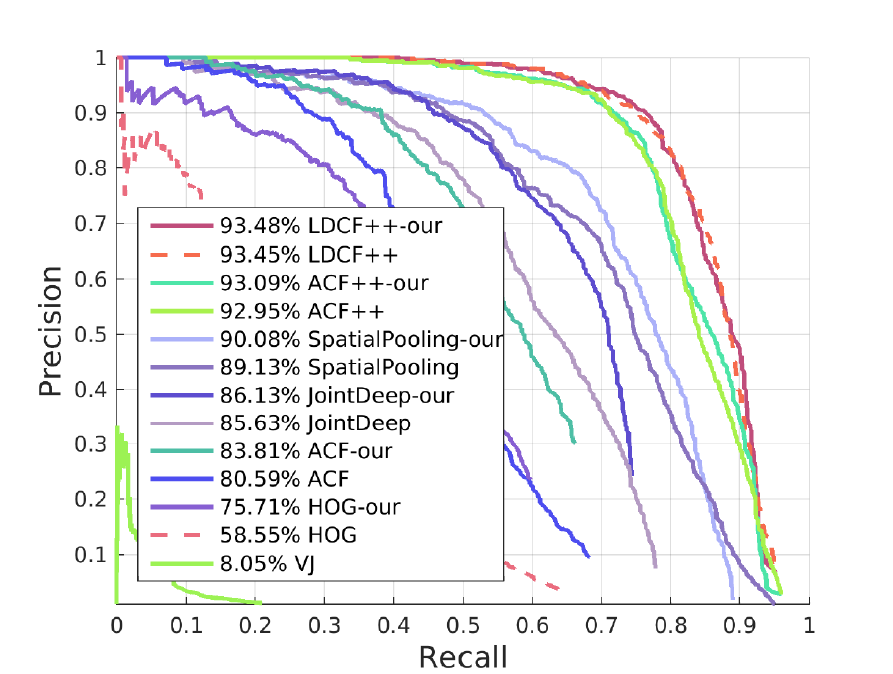
Figure 11. PR curves of algorithms with and without our